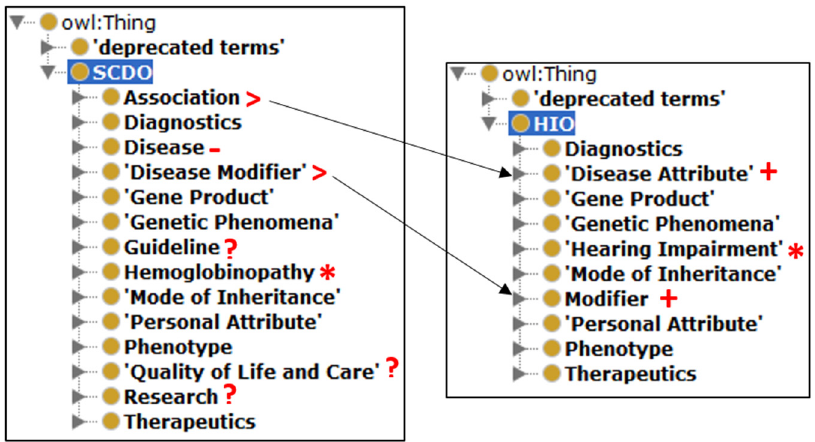
Figure 2. The upper classes of the Sickle Cell Disease Ontology (SCDO) and HI Ontology (HIO). (*) indicates the ontologies’ central classes. (+) indicates classes in HIO but not in the SCDO. (-) indicates a class in SCDO but not in HIO. (>) indicates classes in SCDO that were incorporated in other HIO classes. (?) indicates SCDO classes that still need to be reviewed and adapted as necessary for inclusion into the HIO.